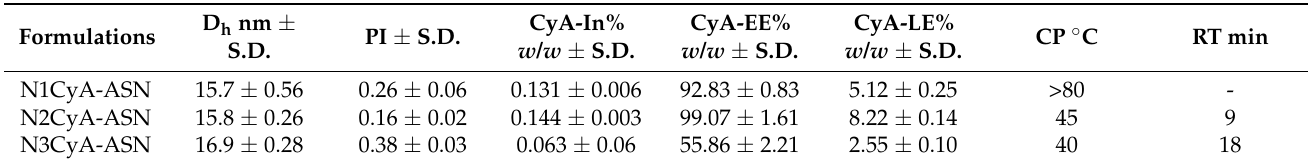
Table 3. Size (D h ), polydispersity index (PI), CyA-In, CyA-EE, CyA-LE, cloud point (CP) and regeneration time (RT) of NxCyA-ASN, (mean, n =